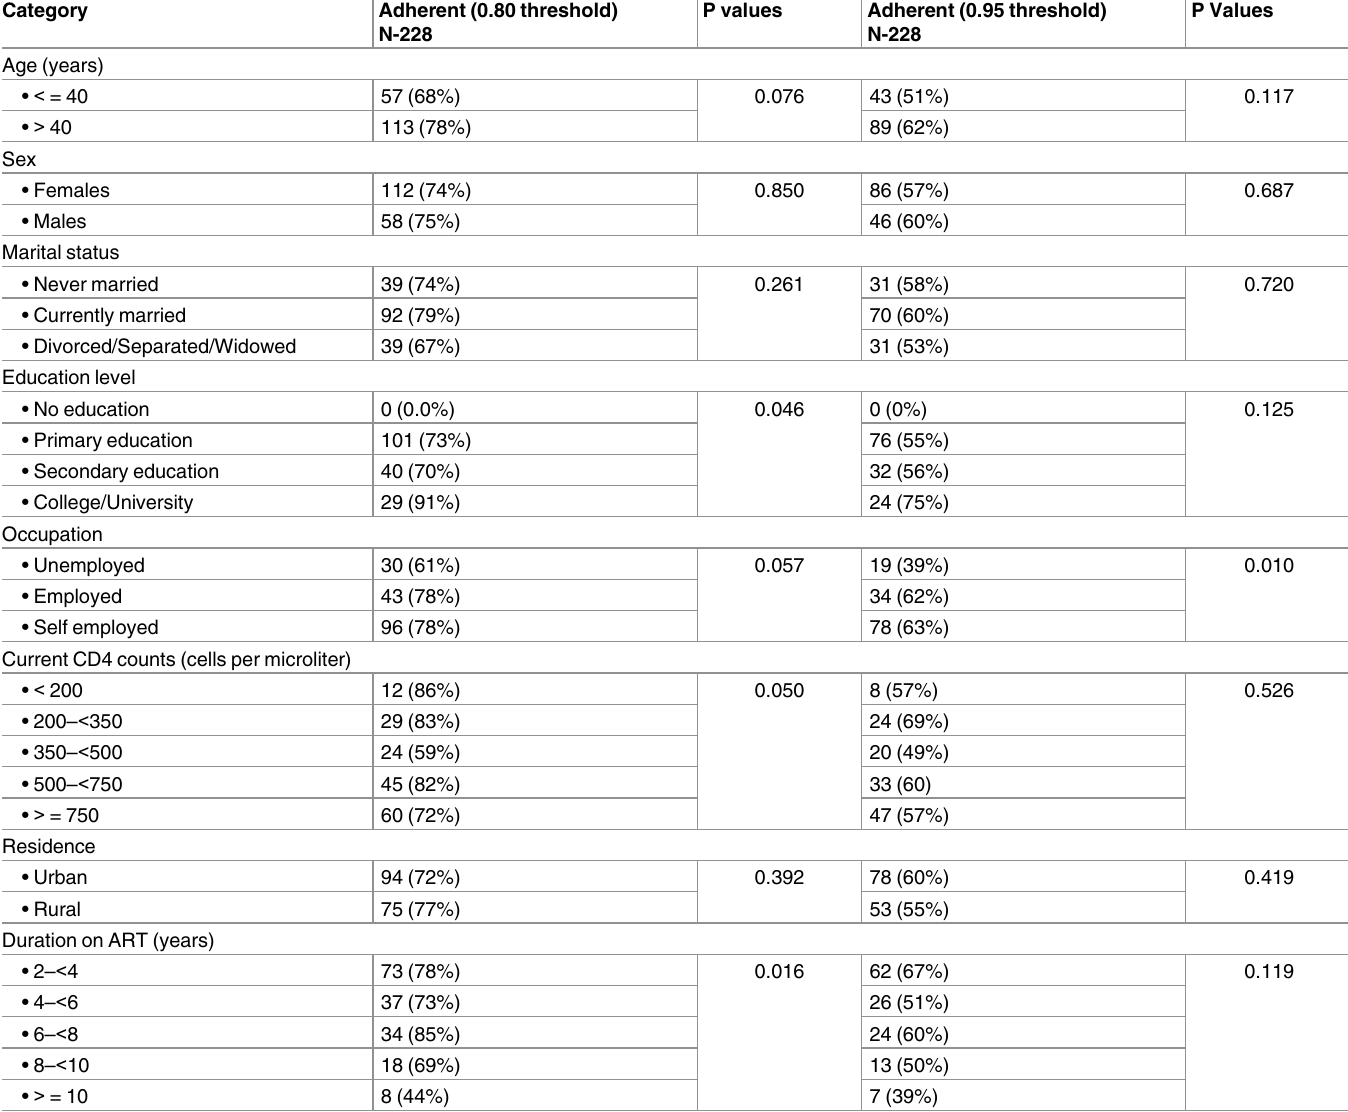
Table 3. Adherence of interviewed participants based on demographic